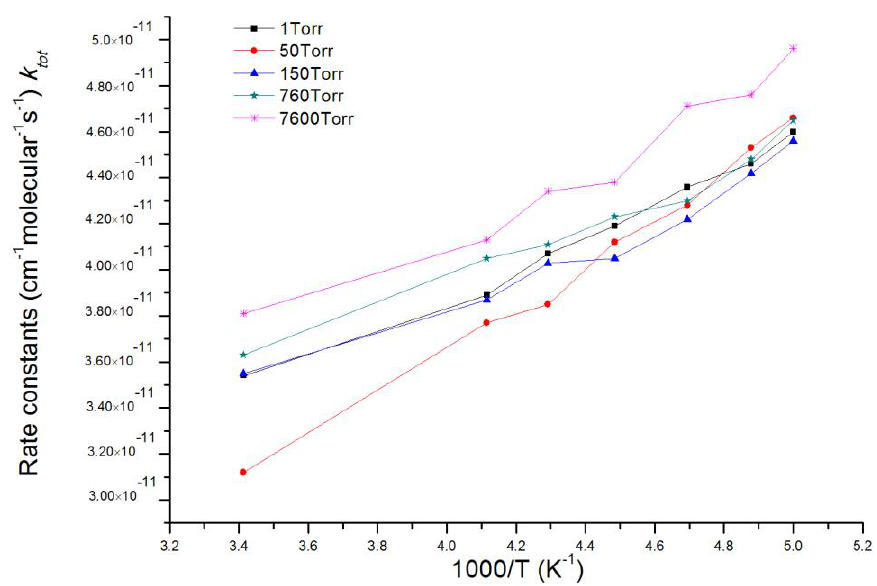
Figure 3. The total reaction rate constant ( k tot ) at various pressures of 1, 50, 150, 760 and 7600 Torr in a temperature range of 200~293 K.